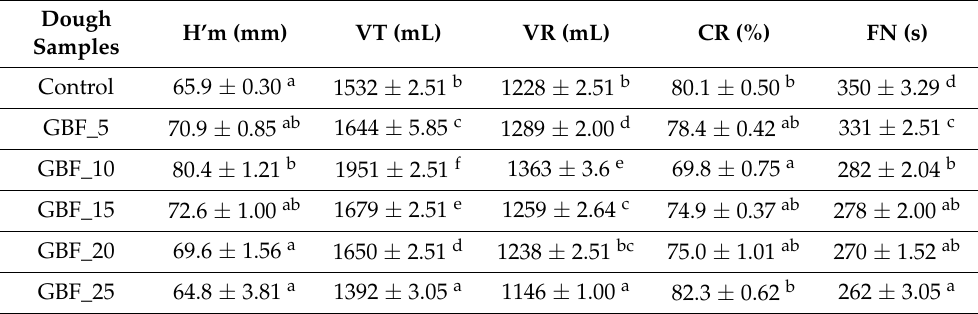
Table 3. Rheofermentometer parameters and falling number values of dough samples with different levels of germinated bean flour (BGF)